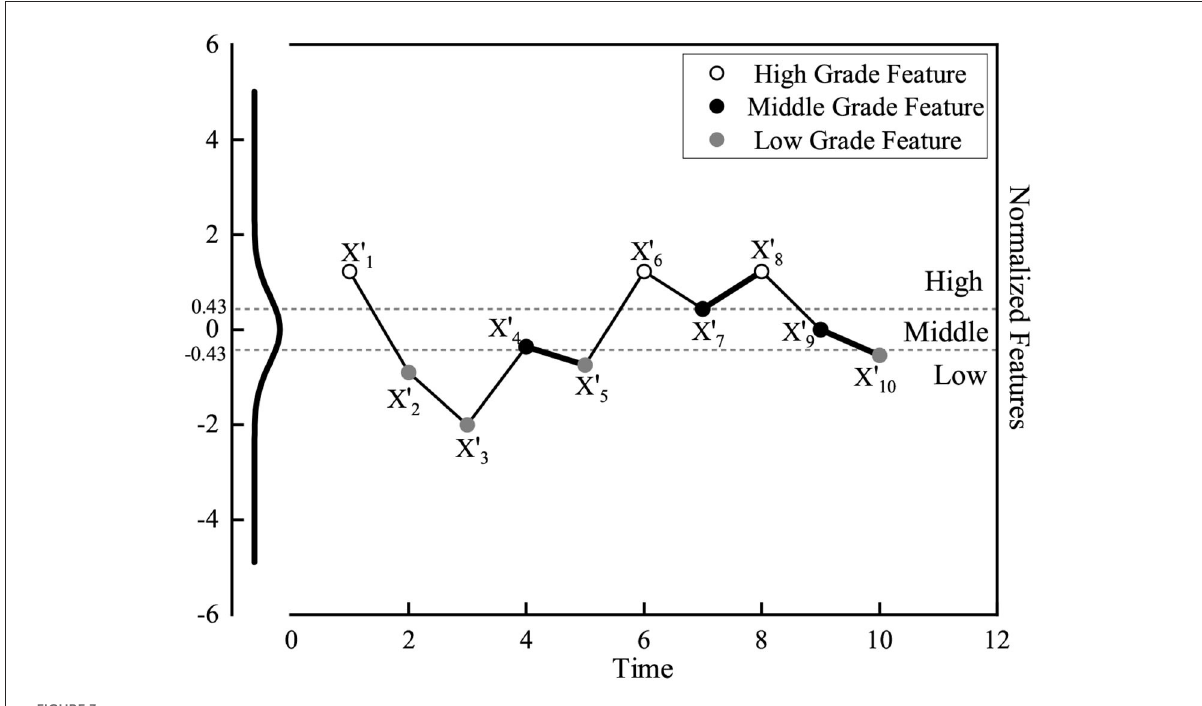
FIGURE3 The grading results of